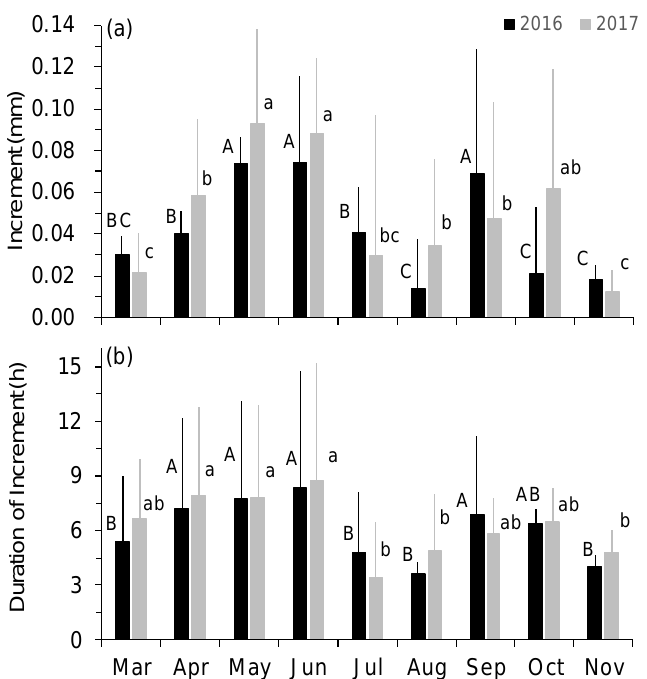
Figure 6. Variations of monthly mean magnitude ( a ) and duration ( b ) of stem increment during the two growing seasons. Different letters indicate significant difference in magnitude and duration of stem increment among months in 2016 (uppercase) and 2017 (lowercase) at p < 0.05. Error bars indicate ± SD of mean.